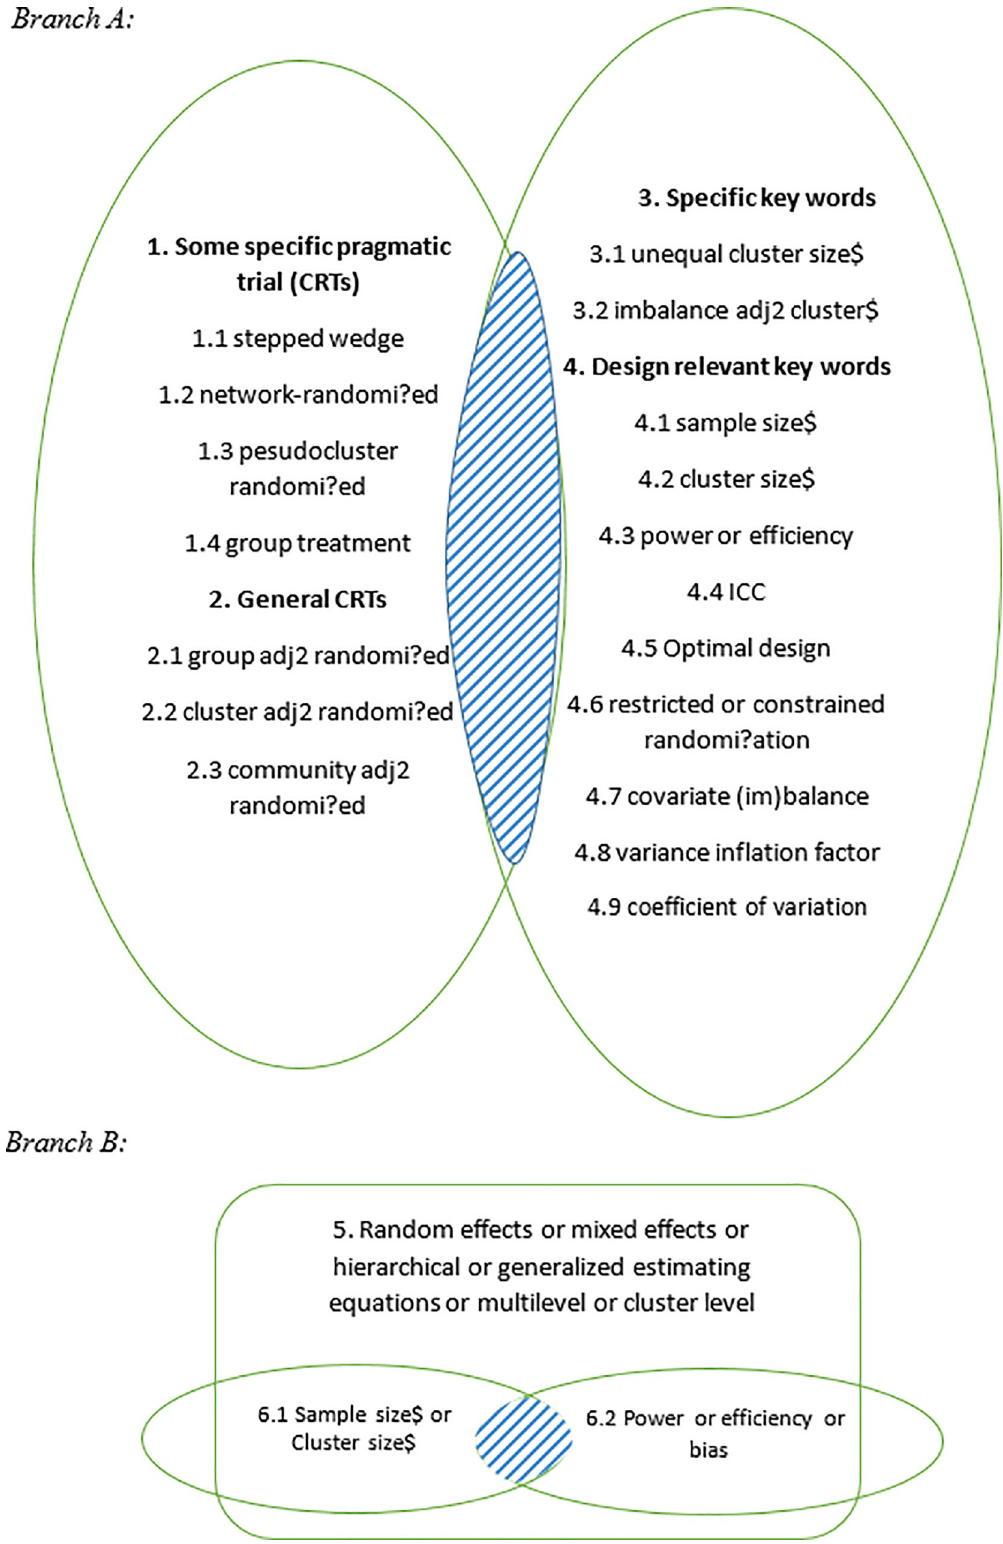
Fig 1. Two branches indicating the search strategies in Medline and